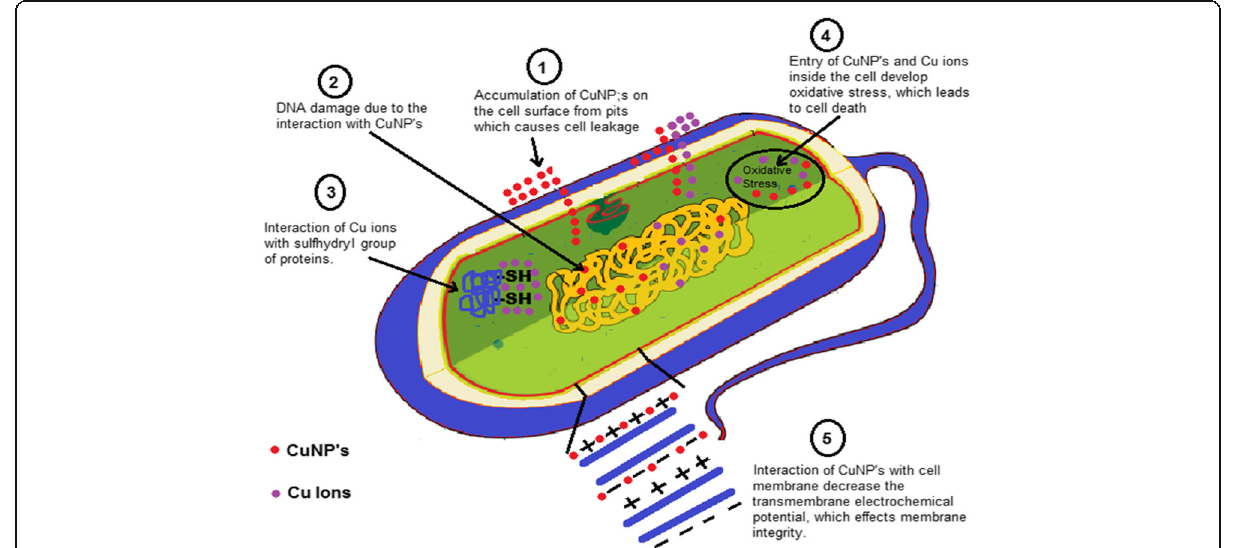
Fig. 6 Mechanism for antibacterial activity of copper nanoparticles